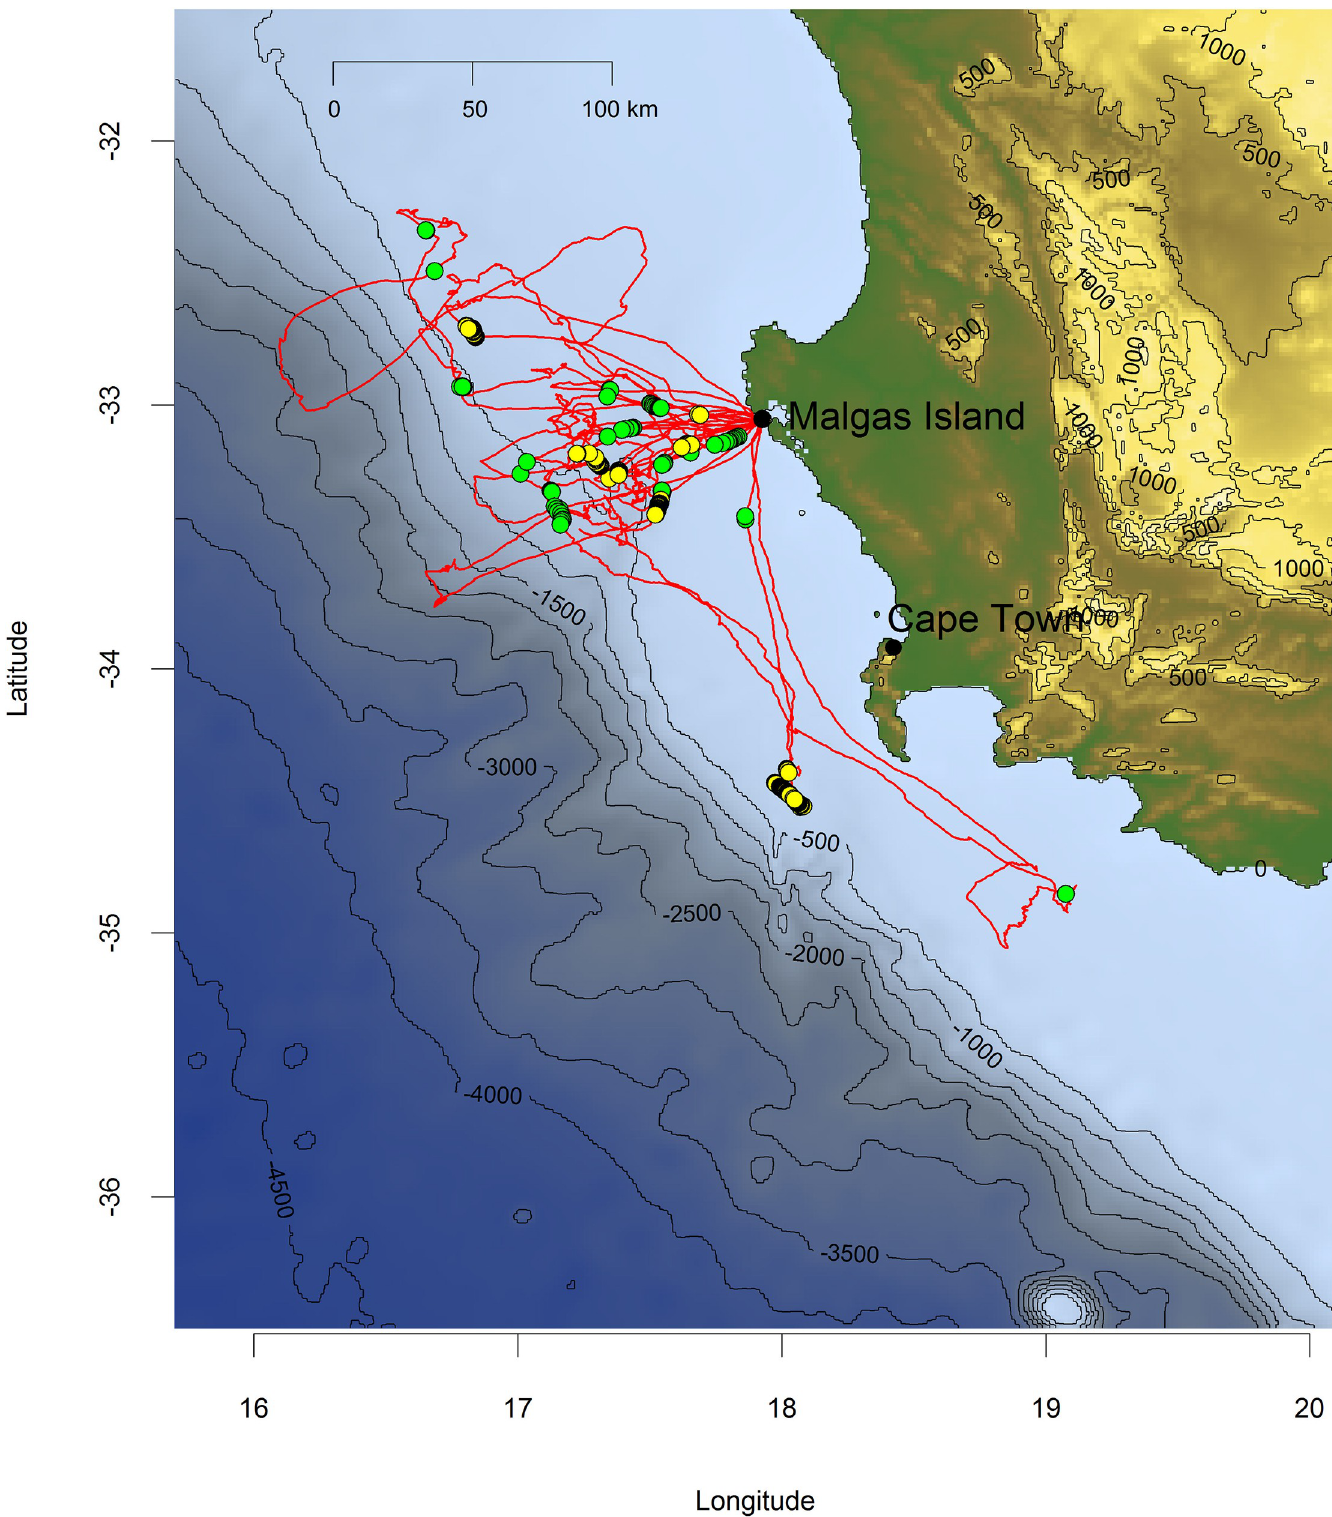
Fig 5. Foraging tracks of 13 Cape gannets during which vessel radar was detected. The seven detections with true bird-vessel attendance are indicated with yellow dots, whereas another 21 detections (green dots) featured short ( < 10 min) bird-vessel overlaps. Blue shades indicate bathymetry (R package marmap).